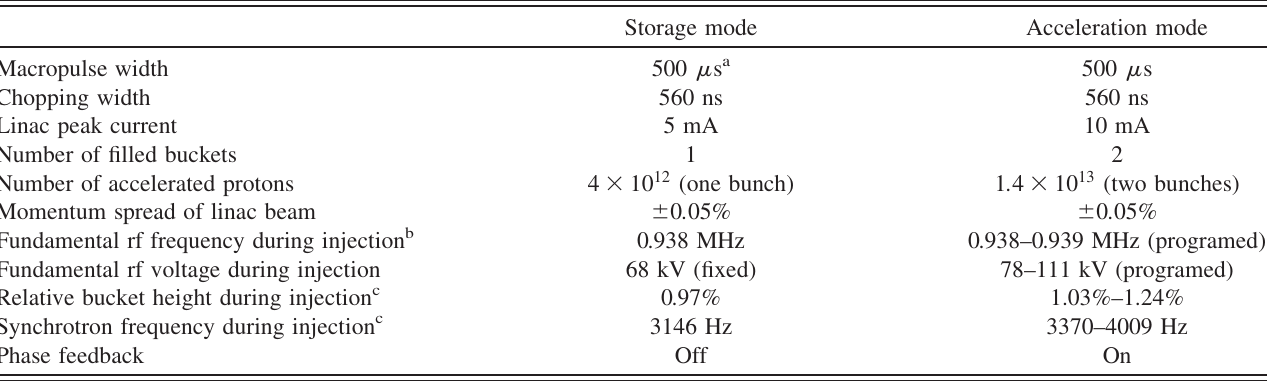
TABLE II. Beam test